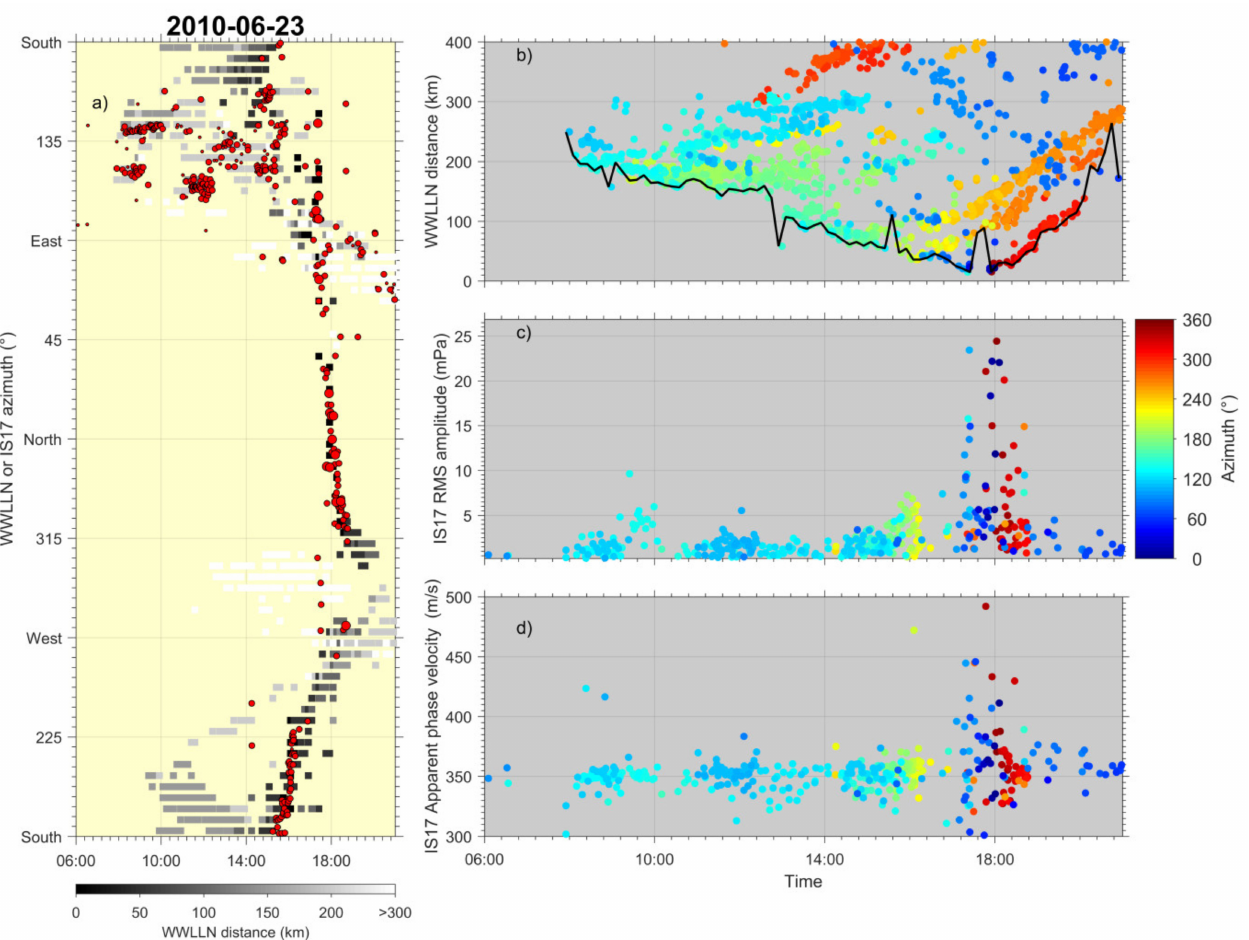
Figure 5. Comparison of infrasound measurements and WWLLN flash detections on 23 June 2010 from 6 UT to 20 UT. ( a ) Comparison of the azimuths of the infrasound detections with the ones of the flashes as shown in Figure 4. ( b ) Temporal variation of the flash distance color-coded with the WWLLN flash azimuth. The black line is the distance of the closest flash per 5-min interval. ( c ) Temporal variation of the infrasound RMS amplitude color-coded with the infrasound azimuth. ( d ) Temporal variation of the infrasound apparent phase velocity color-coded with the infrasound